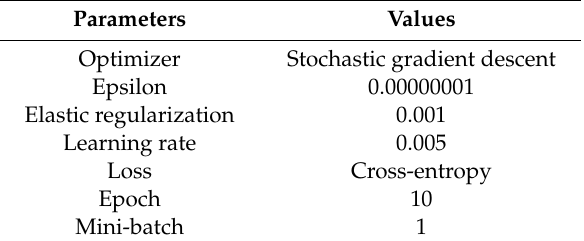
Table 1. DNN hyper-parameters.